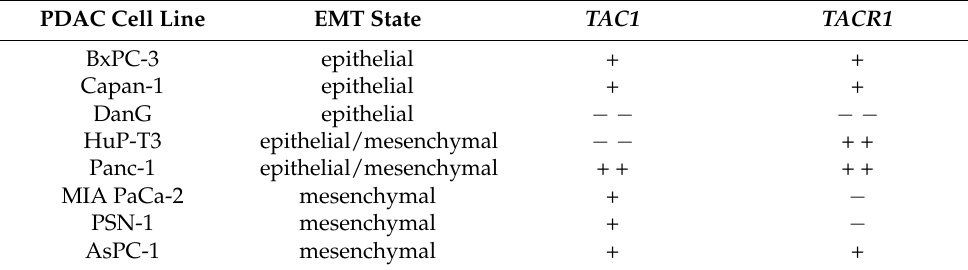
Table 1. PDAC cell line characteristics and CCLE gene